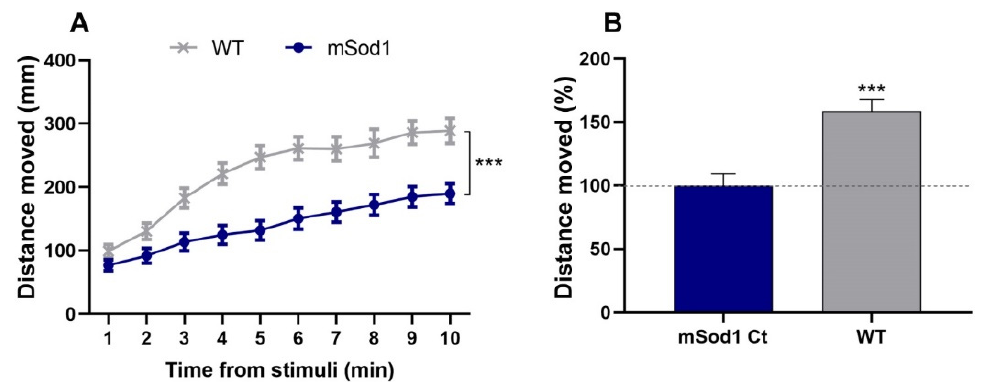
Figure 1. SOD1 G93R mutant locomotor activity. ( A ) The distances that 6 dpf WT and mSOD1 larvae swam following light stimuli per 1 min time bin were measured and averaged (*** p < 0.001; linear mixed effect model; n = 48/group). ( B ) The change (%) in the distance that the WT larvae swam compared to mSod1 larvae. The distances were averaged per fish for the whole 10 min period following light stimuli, scaled per plate and compared between conditions (*** p < 0.001; linear mixed effect model; n = 48/group).